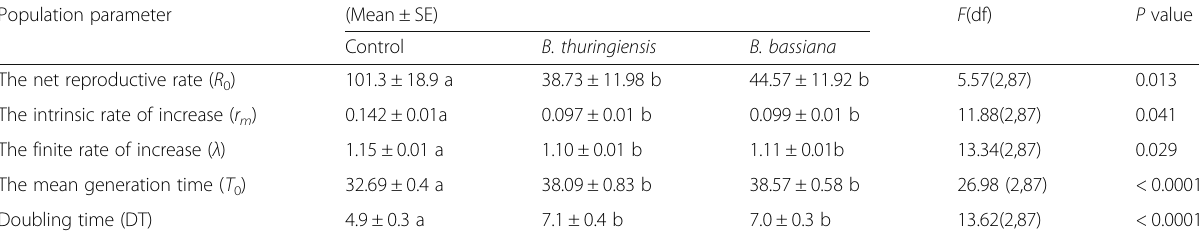
Table 6 Life table parameters (mean ± SE) of T. absoluta treated as second instar larvae by LC 50 values of B. thuringiensis or B.